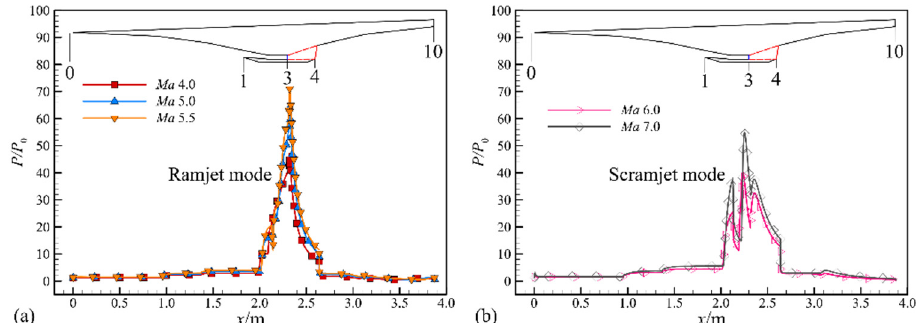
Figure 12. Static pressure ratios at off-design points from Mach 4 to 6. ( a ) Static pressure ratio of the hypersonic vehicle in ramjet mode; ( b ) static pressure ratio of the hypersonic vehicle in scramjet mode.